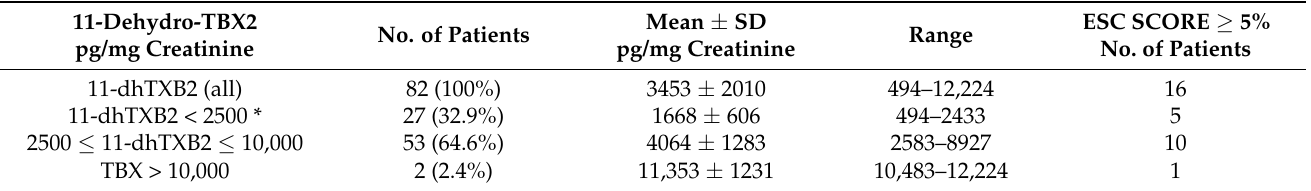
Table 3. Urinary 11-dehydro-thromboxane B2 (11-dehydro-TBX2) levels in the study group with stratification according to the algorithm by Lopez et al., 2014